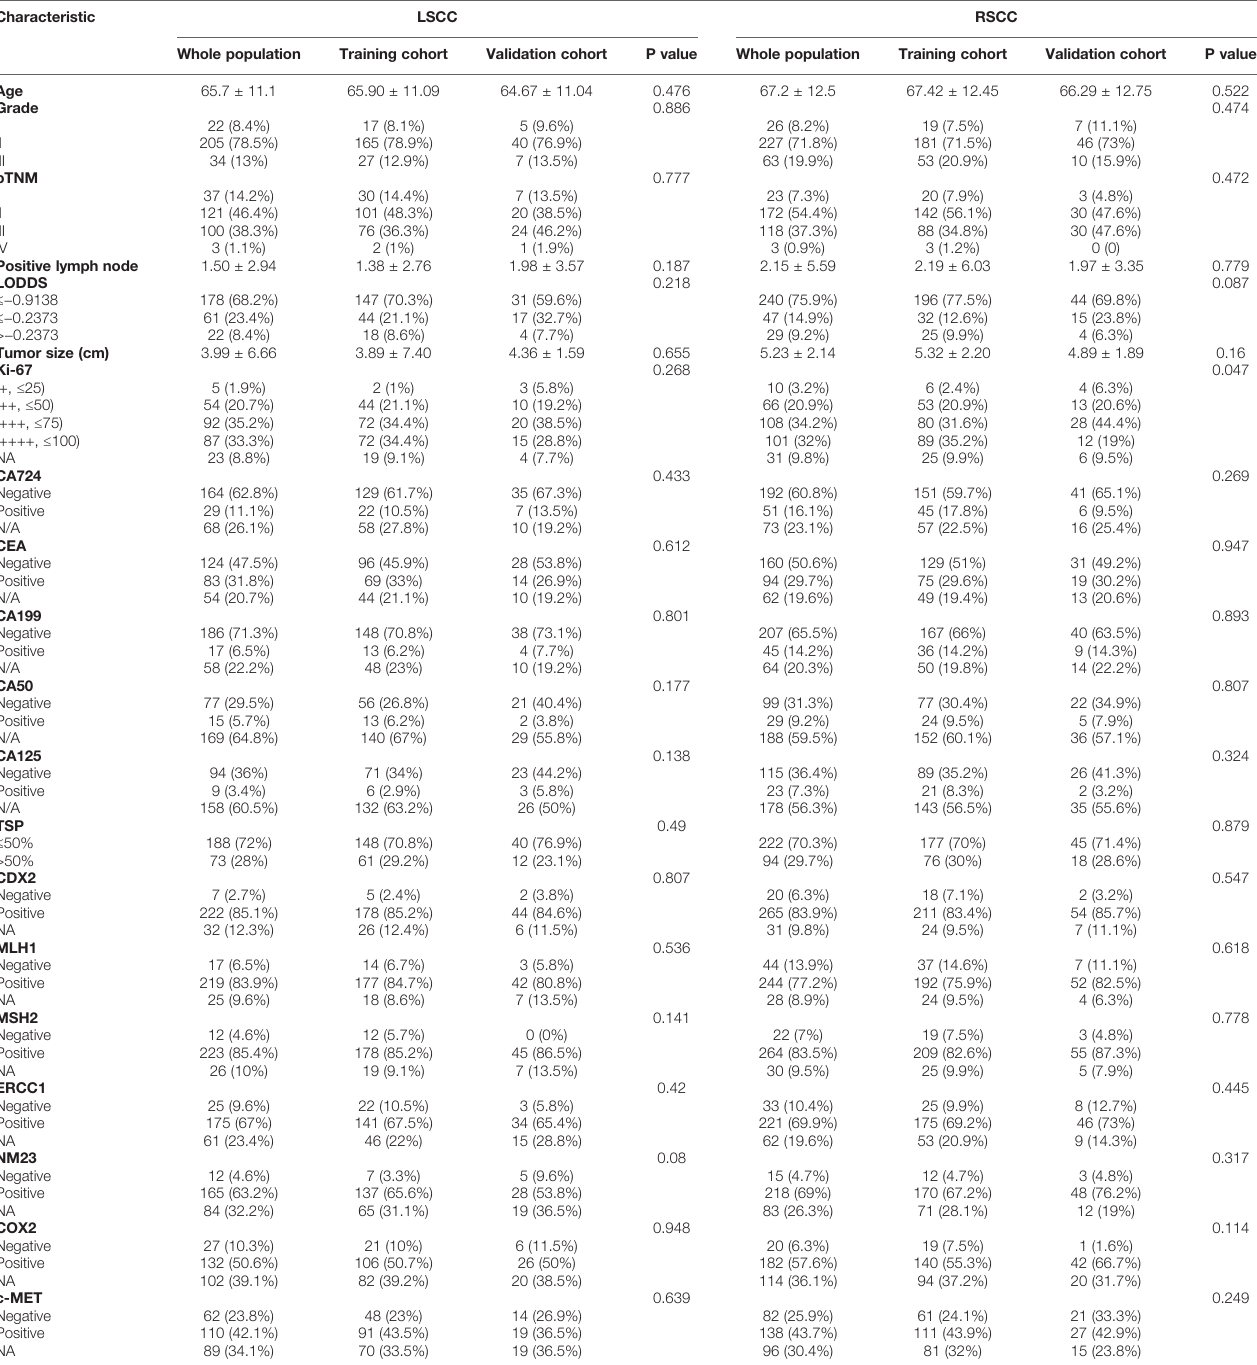
TABLE 1 | Demographics and clinical characteristics of CC patients.